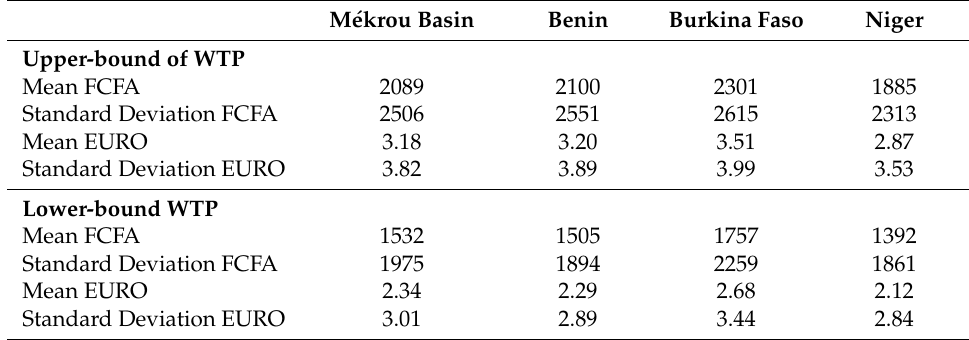
Table 10. Willingness to pay: annual household maximum and minimum WTP for domestic water provision.